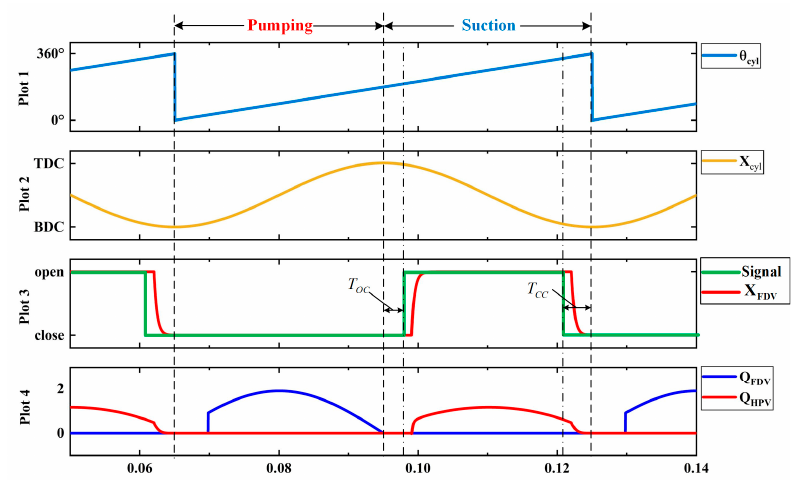
Figure 3. Perfect flow distribution state: plot 1: rotational angle; plot 2: Piston displacement; plot 3: The spool position and control signal; plot 4: FDV and HPV flow rate.